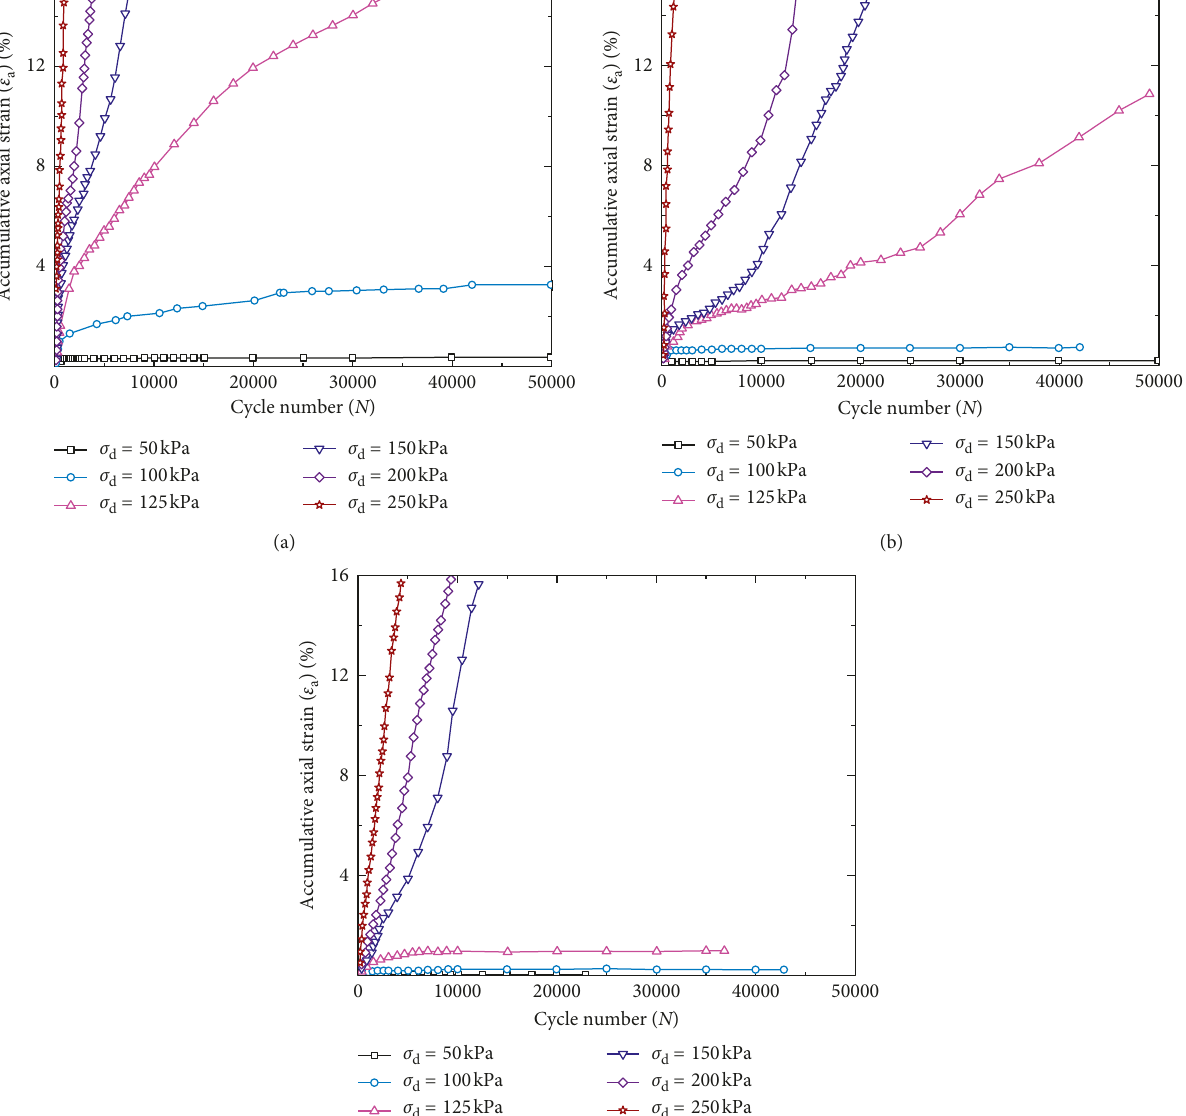
3 (cid:31) 15kPa; (b) σ 3 (cid:31) 30kPa; (c) σ 3 (cid:31)